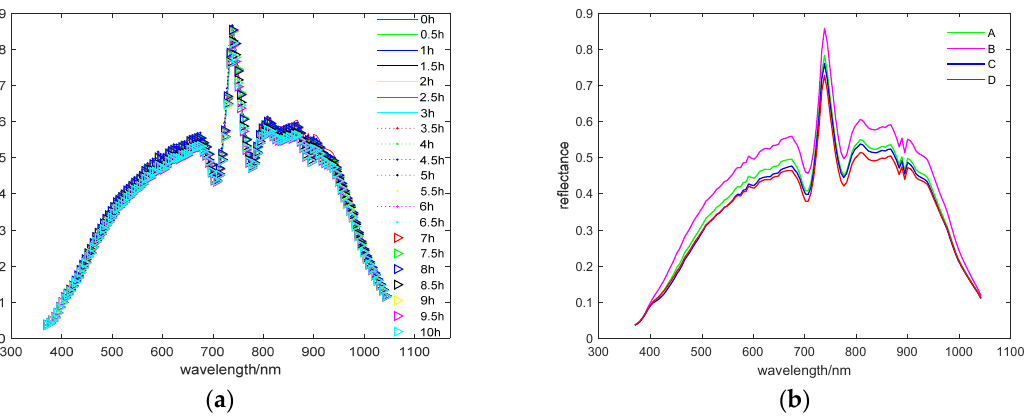
Figure 5. The average spectrum of ( a ) grade B seeds within 10 h of germination; ( b ) the four viability grade seeds over the entire process.